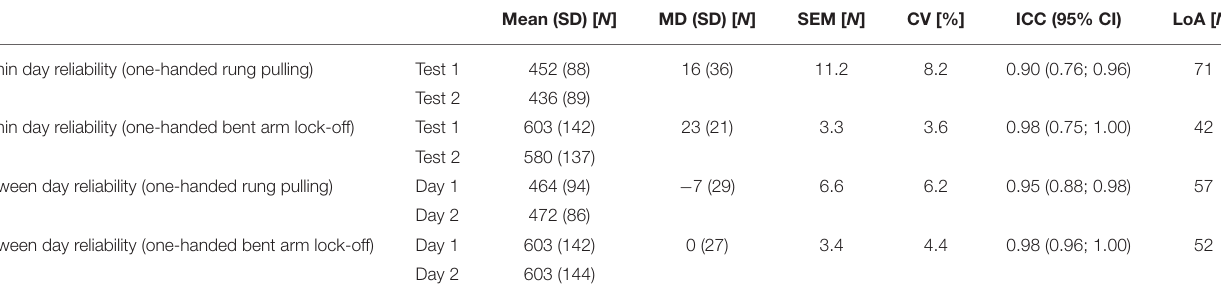
TABLE 4 | Within-day and between-day reliability indicators for Tindeq in the free-hanging